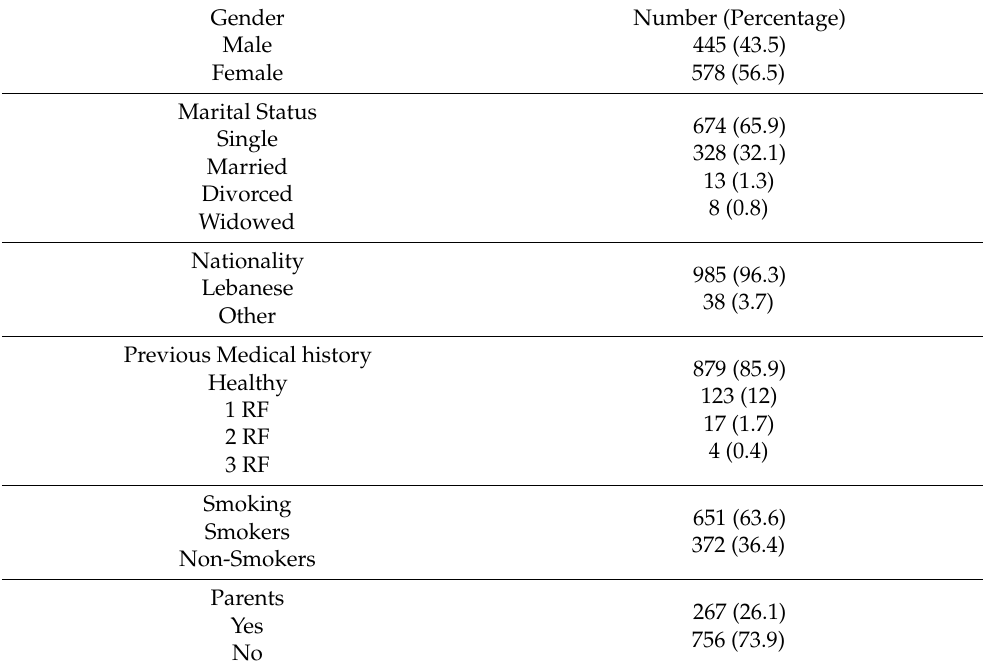
Table 1. Descriptive Demographic data (N = 1023), LAUMCRH, January 2020–January